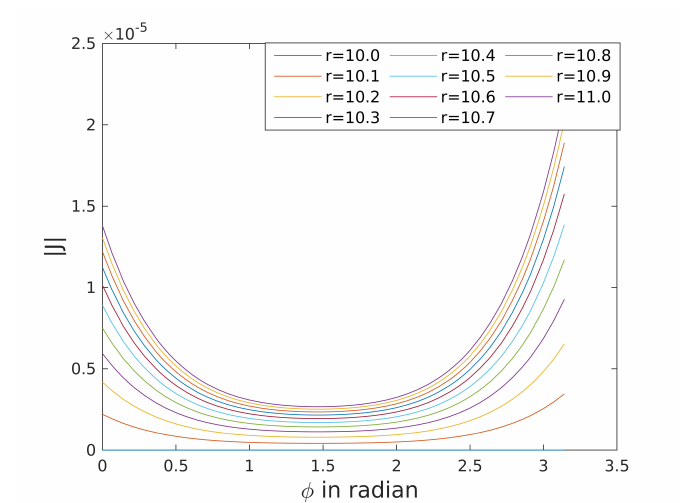
Figure 11. Determinant of the observability Jacobian for different radii on the Sixdays track with r 0 =